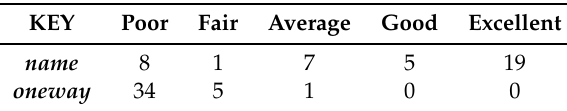
Table 4. Summary of compliance of all cities with suggested tag key combinations for the target tag highway=residential .